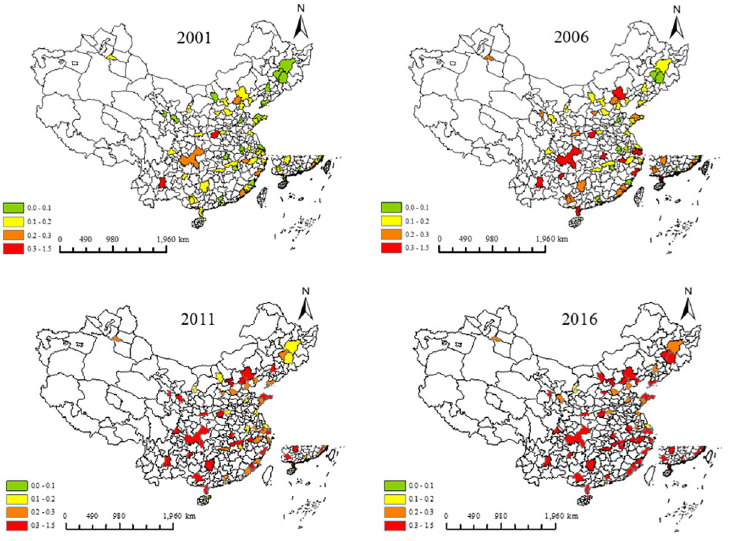
Fig 3. Urban tourism efficiency of 58 cities in 2001, 2006, 2011 and